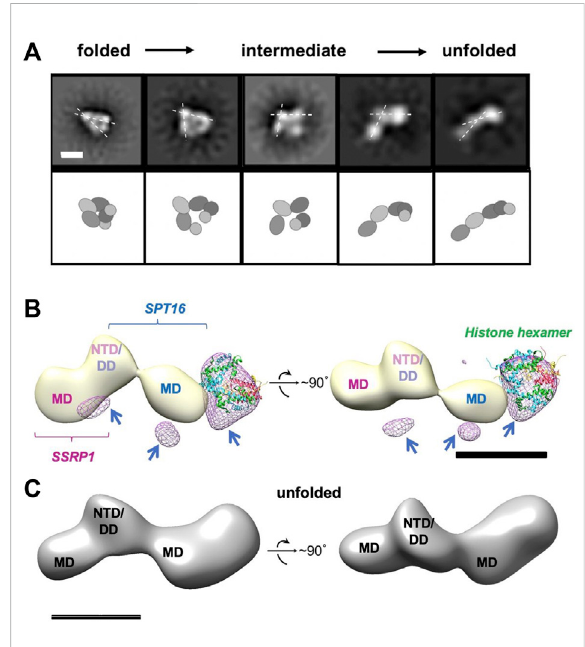
FIGURE 6 Unfolding of FACT-nucleosome complex in presence of curaxin CBL0137. (A) Step-by-step complex unwrapping by FACT inthepresenceofCBL0137.Top:Characteristic2Dclass-averages of FACT-nucleosome complexes (in the presence of CBL0137). Dashed lines indicate the angle between SSRP1 MD- NTD/SPT16DD-MDdomains,whichincreasesduringnucleosome unfolding. Bar — 10 nm. Bottom: Schematic of the proposed domain rearrangements as shown in the upper panel, (B) Difference map between unfolded FACT-nucleosome complex and FACT in the open state (light yellow); the resulting differential density is shown in magenta mesh. Histone hexamers (H2A/H2B dimer and H3/H4 tetramer derived from 6UPK PDB) were fi tted into the differential density with correlation coef fi cient of 0.88; arrows are pointing to the additional differential densities, which can be attributed to the DNA bound to the complex; (C) Model of the unfolded FACT-nucleosome complex. Hypothetical position of DNA (purple) is based on the assumption that both SPT16-DD/ MD and SSRP1-DD/MD domains maintain their interactions with DNA previously observed in the compact complex (Liu et al.,